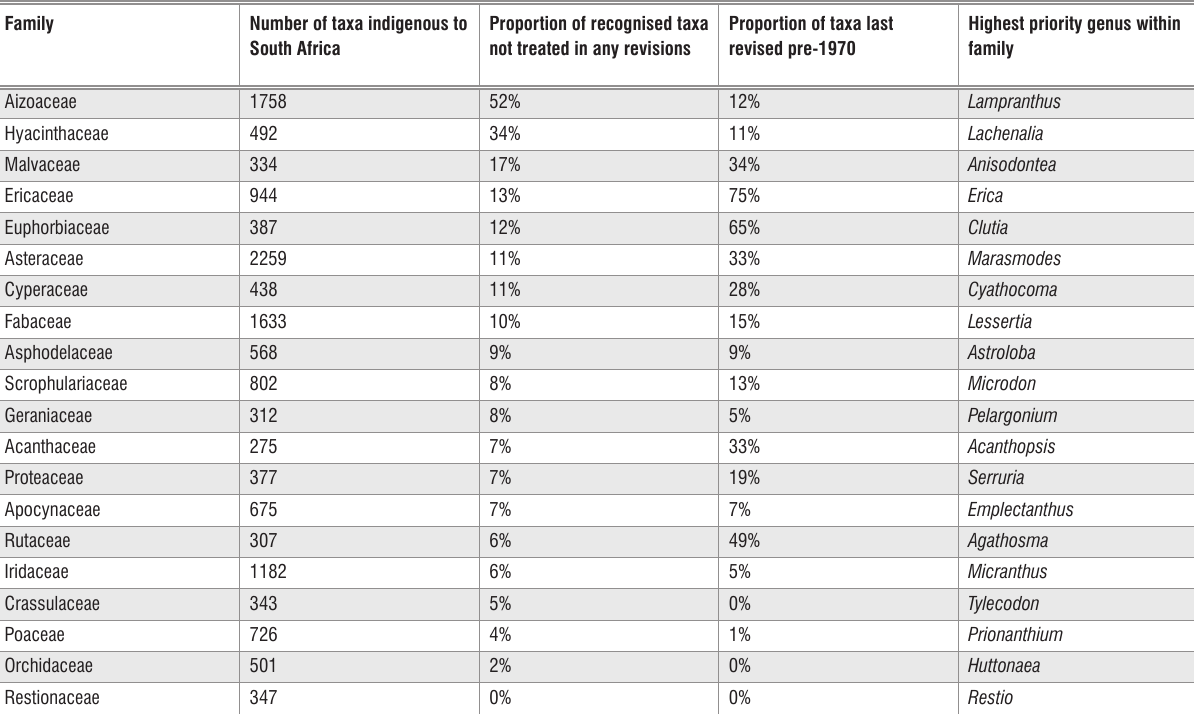
Table 1: South Africa’s 20 largest plant families, in order of priority (highest to lowest) in terms of taxa in need of revision, with the top priority genus within each family